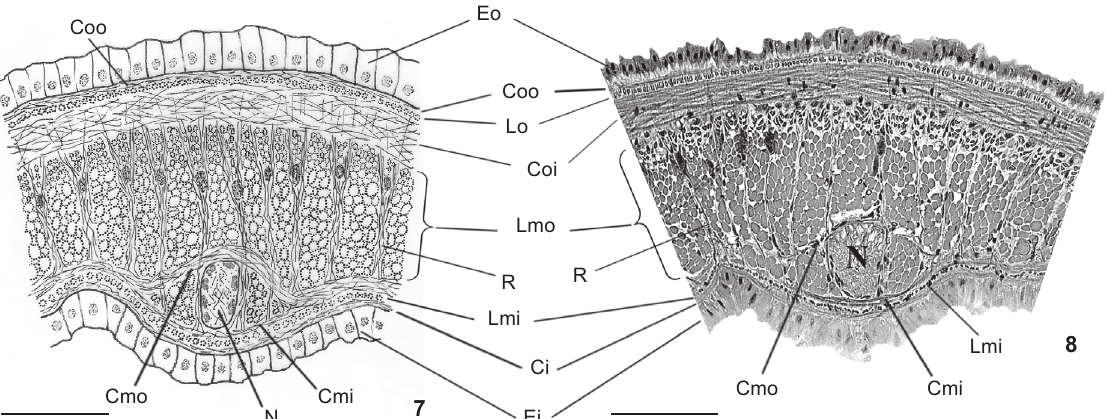
Figures 7-8. Tellina lineata . Diagrammatic representation (7) of the cross section (8) of the exhalant siphon. (Ci) Inner circular layer, (Cmi and Cmo) inner and outer parts of the median circular layer, (Coi and Coo) inner and outer parts of the outer circular layer, (Ei) inner epithelium, (Eo) outer epithelium, (Lmi and Lmo) inner and outer parts of the median longitudinal layer, (Lo) outer longitudinal layer, (N) nerve cord, (R) radial fibers. Scale bars: 10